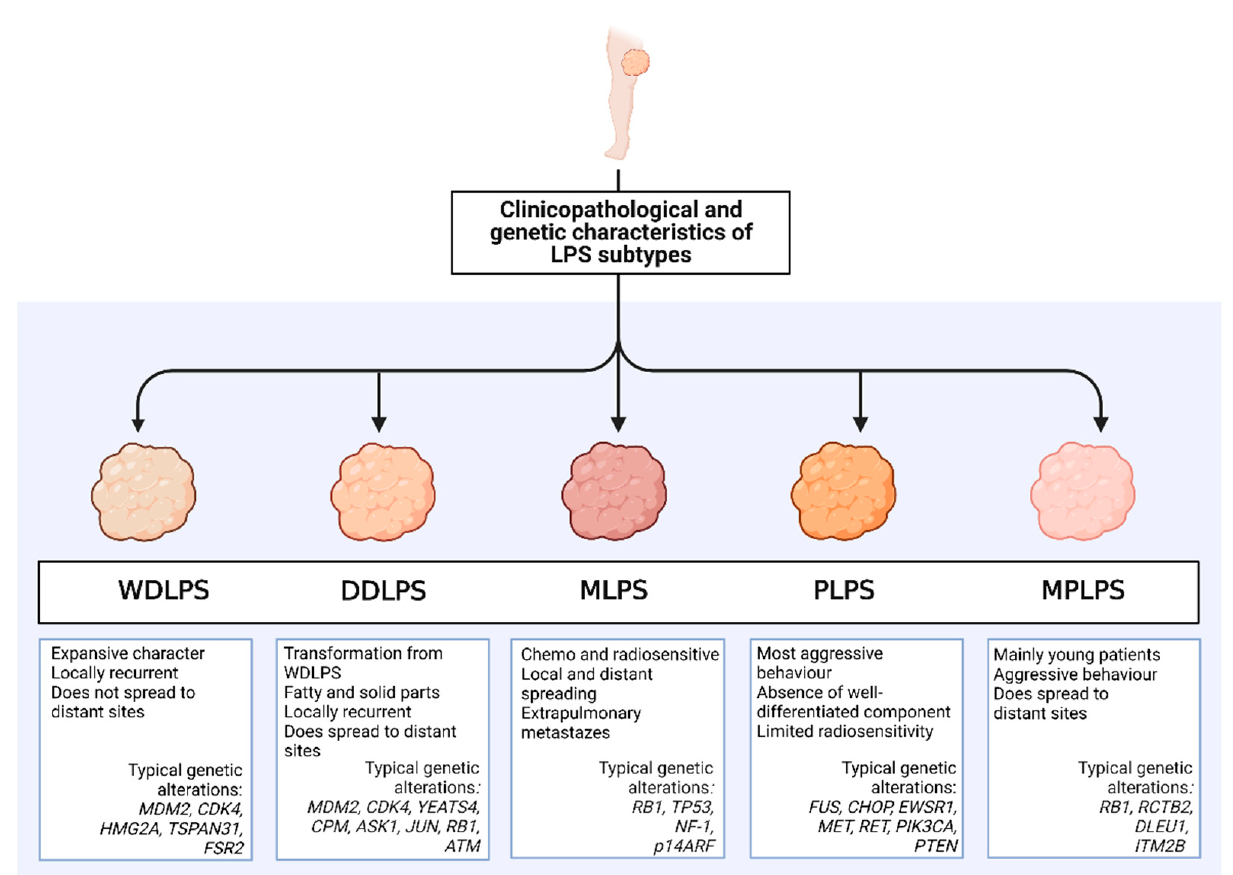
Figure 1. Characteristics of diverse liposarcoma (LPS) subtypes. Five distinct histological subtypes of LPS, including well-differentiated LPS (WDLPS), dedifferentiated LPS (DDLPS), myxoid LPS (MLPS), pleomorphic LPS (PLPS), and myxoid pleomorphic LPS (MPLPS) differ in clinicopathologic features, such as biologic behavior and patterns of disease progression. Genetic alterations in each subtype also display wide variations (Created with Biorender, Agreement No. JR24ANFF0H).